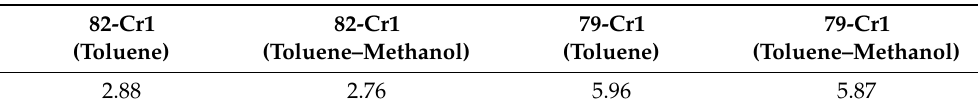
Table 8. Stability constants (lg K a ) of the Cr1 complexes with 82 and 79 in tolueneanda (9:1) toluene– methanol mixture at 20 ◦ C